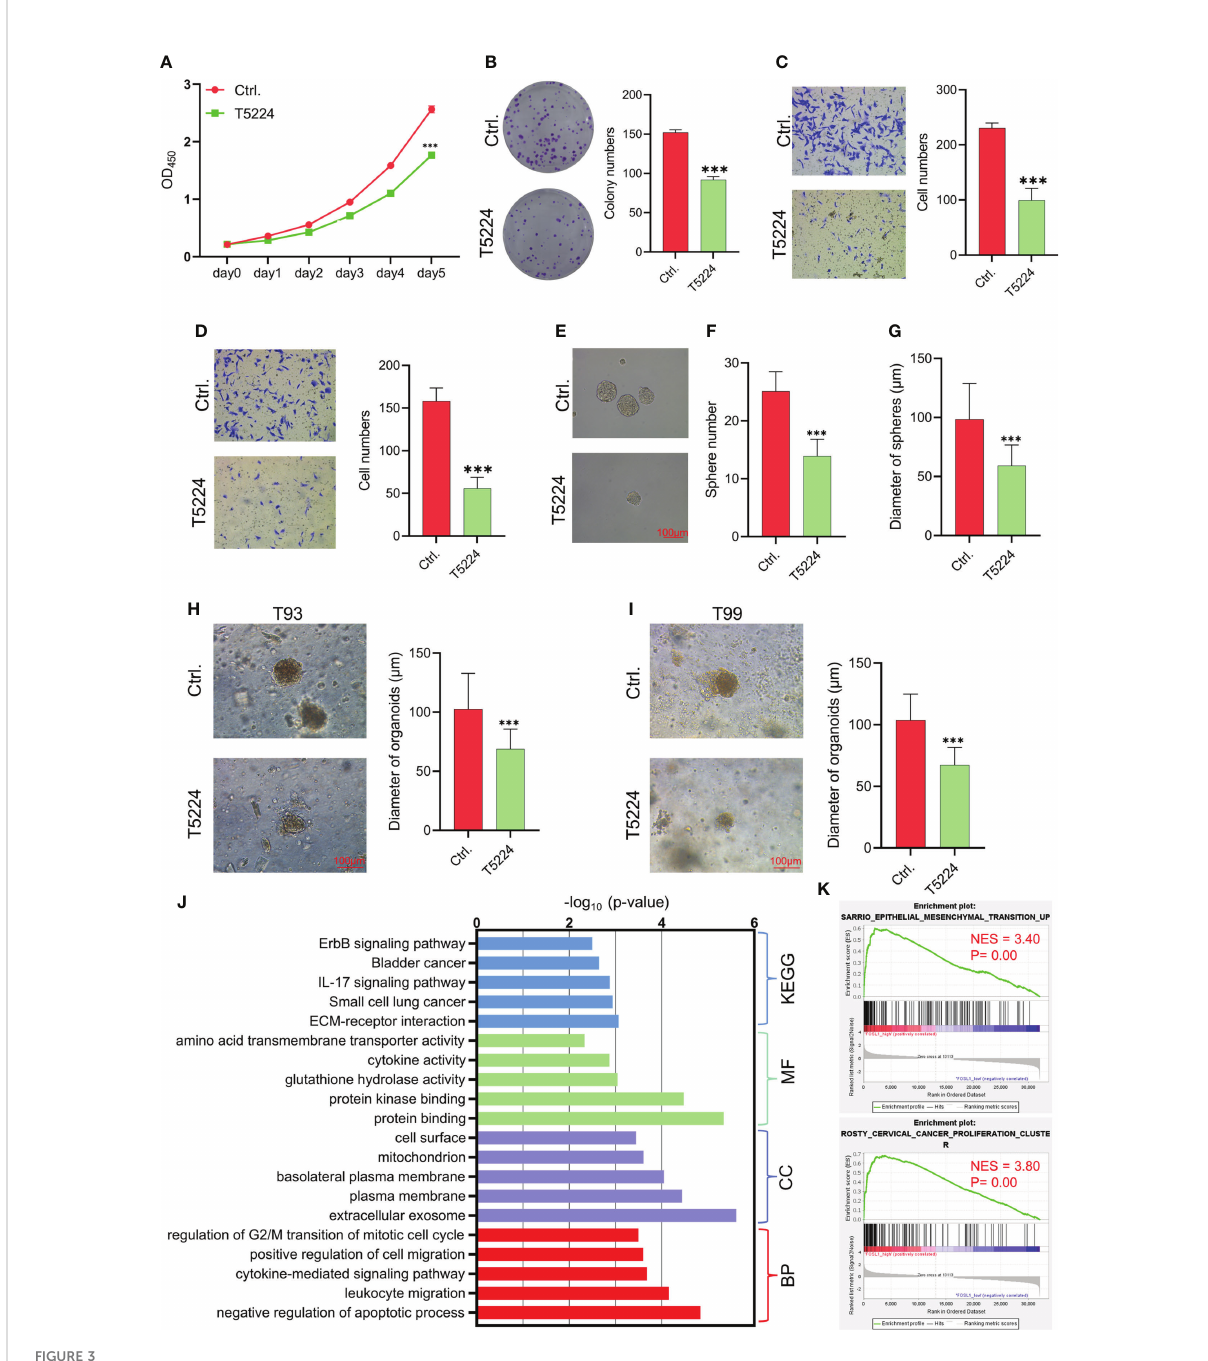
FIGURE 3 Therapeutic target AP1 suppresses the aggressiveness of AM (A – D) CCK-8 assay (A) , colony formation assay (B) , migration assay (C) , and invasion assay (D) were performed on AMs with or without T5244. ***p < 0.001 by two-way ANOVA. (E – G) Tumor sphere formation was performed on AMs with or without T5244. ***p < 0.001 by Student ’ s t-test. (H, I) Organoids were cultured in T93 and T99 patients with or without T5244. ***p < 0.001 by Student ’ s t-test. (J) GO and KEGG analyses of upregulated DEGs in samples with high FOSL1 expression. The top 5 terms are shown based on the -log 10 (p value). BP, biological process; CC, cellular component; MF, molecular function; KEGG, Kyoto Encyclopedia of Genes and Genomes. (K) GSEA showed that cell proliferation- and EMT-associated signatures were highly enriched in samples with high FOSL1 expression. NES, normalized enrichment